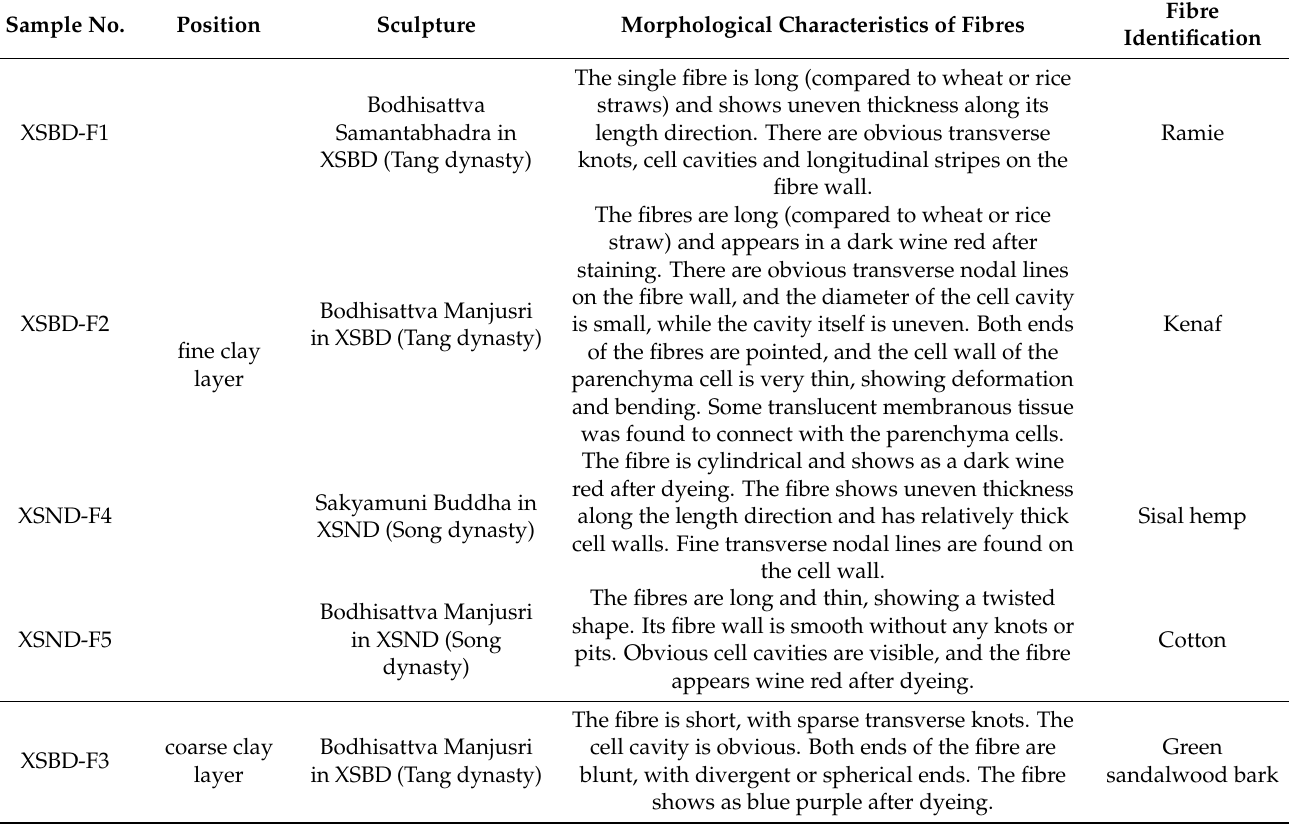
Table 2. Morphological characteristics of fibre samples in clay